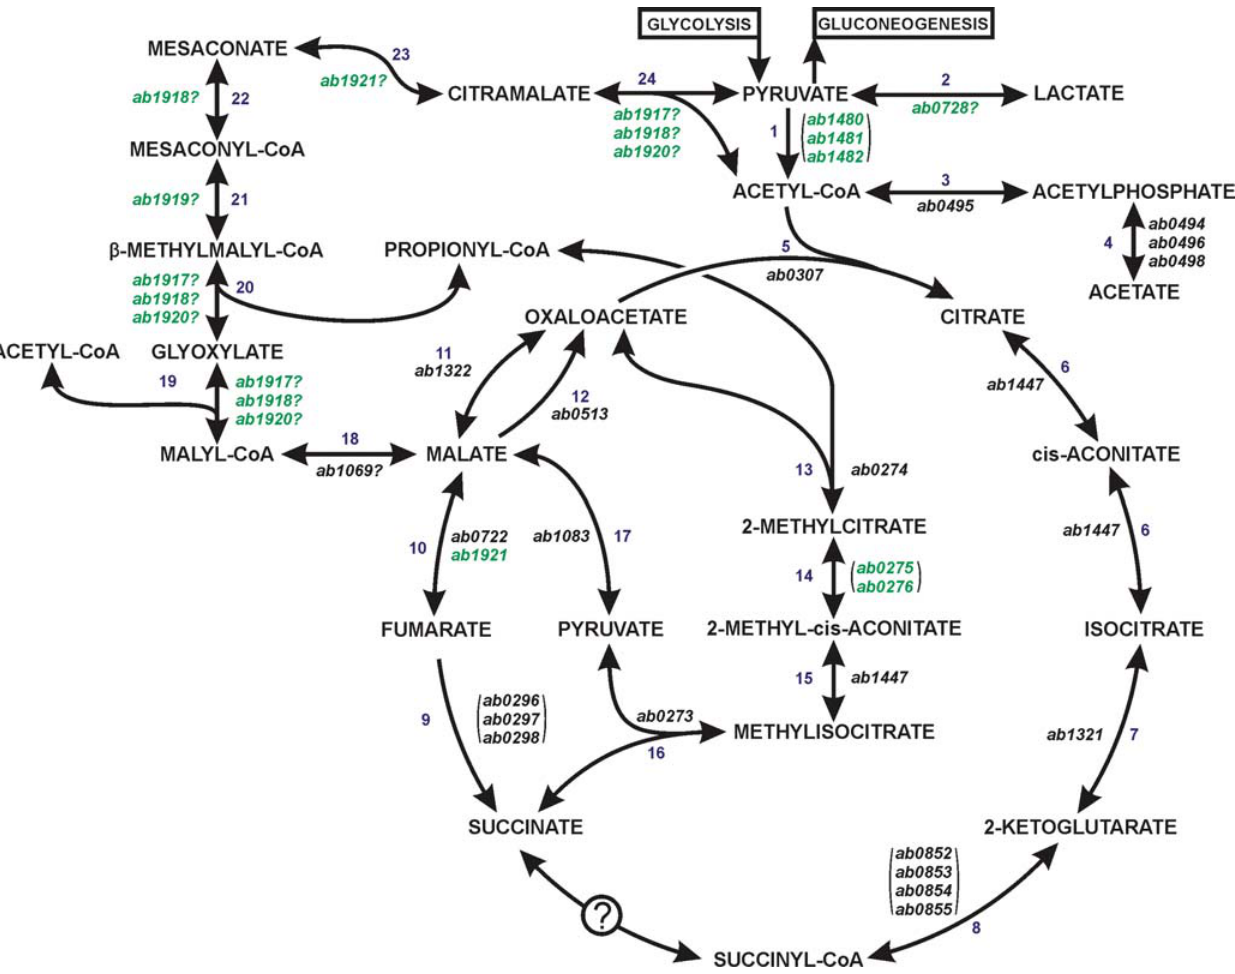
Figure 3. Predicted TCA, methylcitrate and citramalate cycles of A.butzleristrain RM4018. Genes unique within the Campylobacteraceae are labeled in green. Genes in parentheses encode multi-subunit proteins or a protein and its cognate accessory protein. 1: pyruvate dehydrogenase; 2: L-lactate dehydrogenase; 3: phosphate transacetylase; 4: acetate kinase; 5: citrate synthase; 6: aconitase; 7: isocitrate dehydrogenase; 8: 2- oxoglutarate:acceptor oxidoreductase; 9: fumarate reductase; 10: fumarase; 11: malate dehydrogenase; 12: malate:quinone oxidoreductase; 13: 2- methylcitrate synthase; 14: 2-methylcitrate dehydratase; 15: aconitase; 16: 2-methylisocitrate lyase; 17: malic enzyme; 18: malyl-CoA hydrolase; 19: malyl-CoA lyase; 20: b -methylmalyl-CoA lyase; 21: mesaconyl-CoA hydratase; 22: mesaconyl-CoA synthetase; 23: citramalate hydrolase; 24: citramalate lyase.